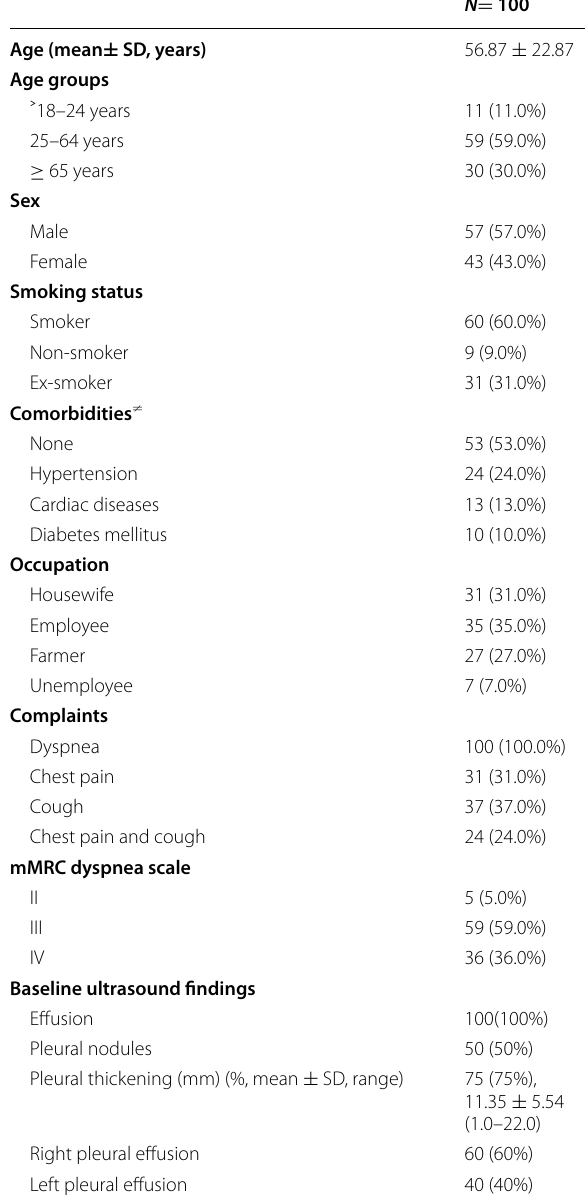
Table 1 Baseline data of studied